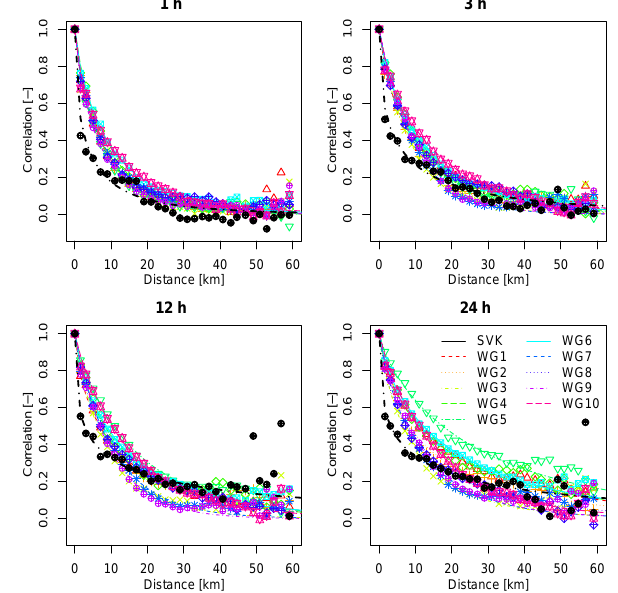
Figure 9. Unconditional spatial correlation for the SVK and WG data sets, calculated from maximum-averaged intensities of extreme events for 1, 6, 12, and 24h duration. Fitted exponential models that highlight overall tendencies are shown. Table 6. e -folding distances for all aggregation periods for all WG